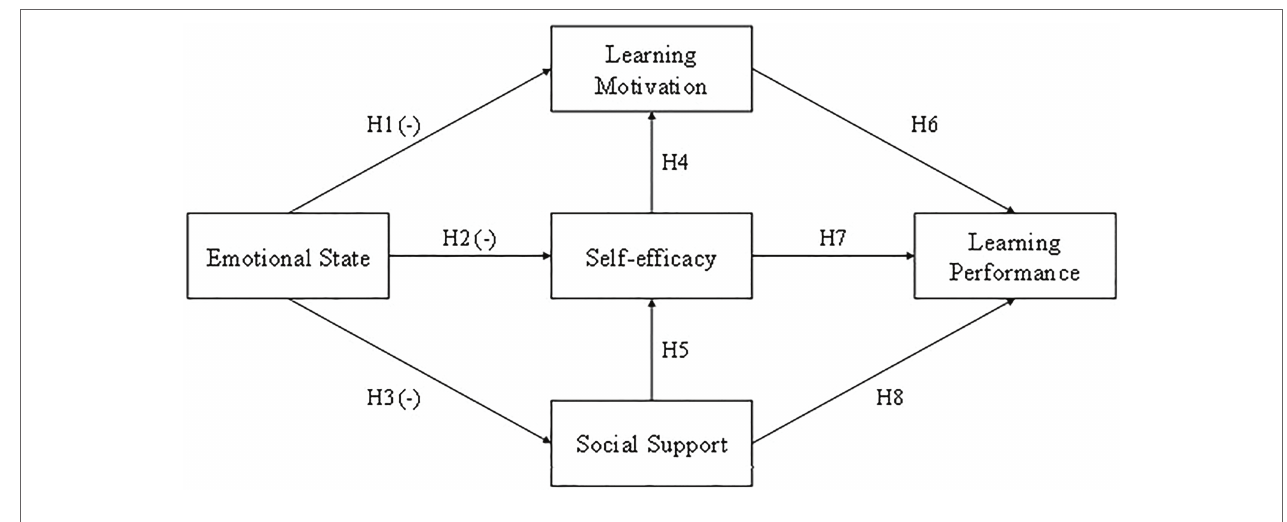
FIGURE 2 | Research model.